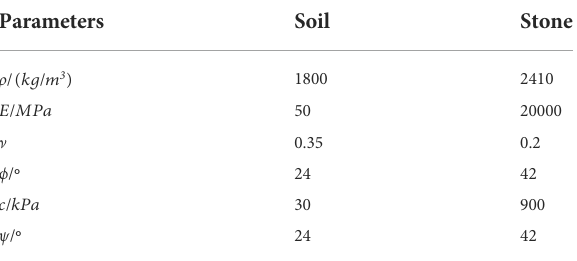
FIGURE 3 Shear zone